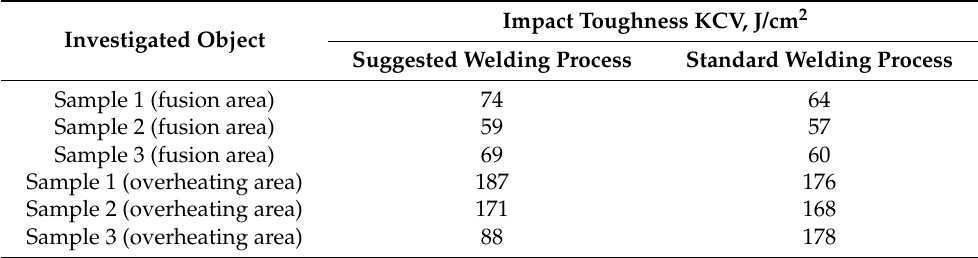
Table 3. Impact toughness of samples with a V-notch along the HAZ (fusion and overheating areas) (Figure 4).